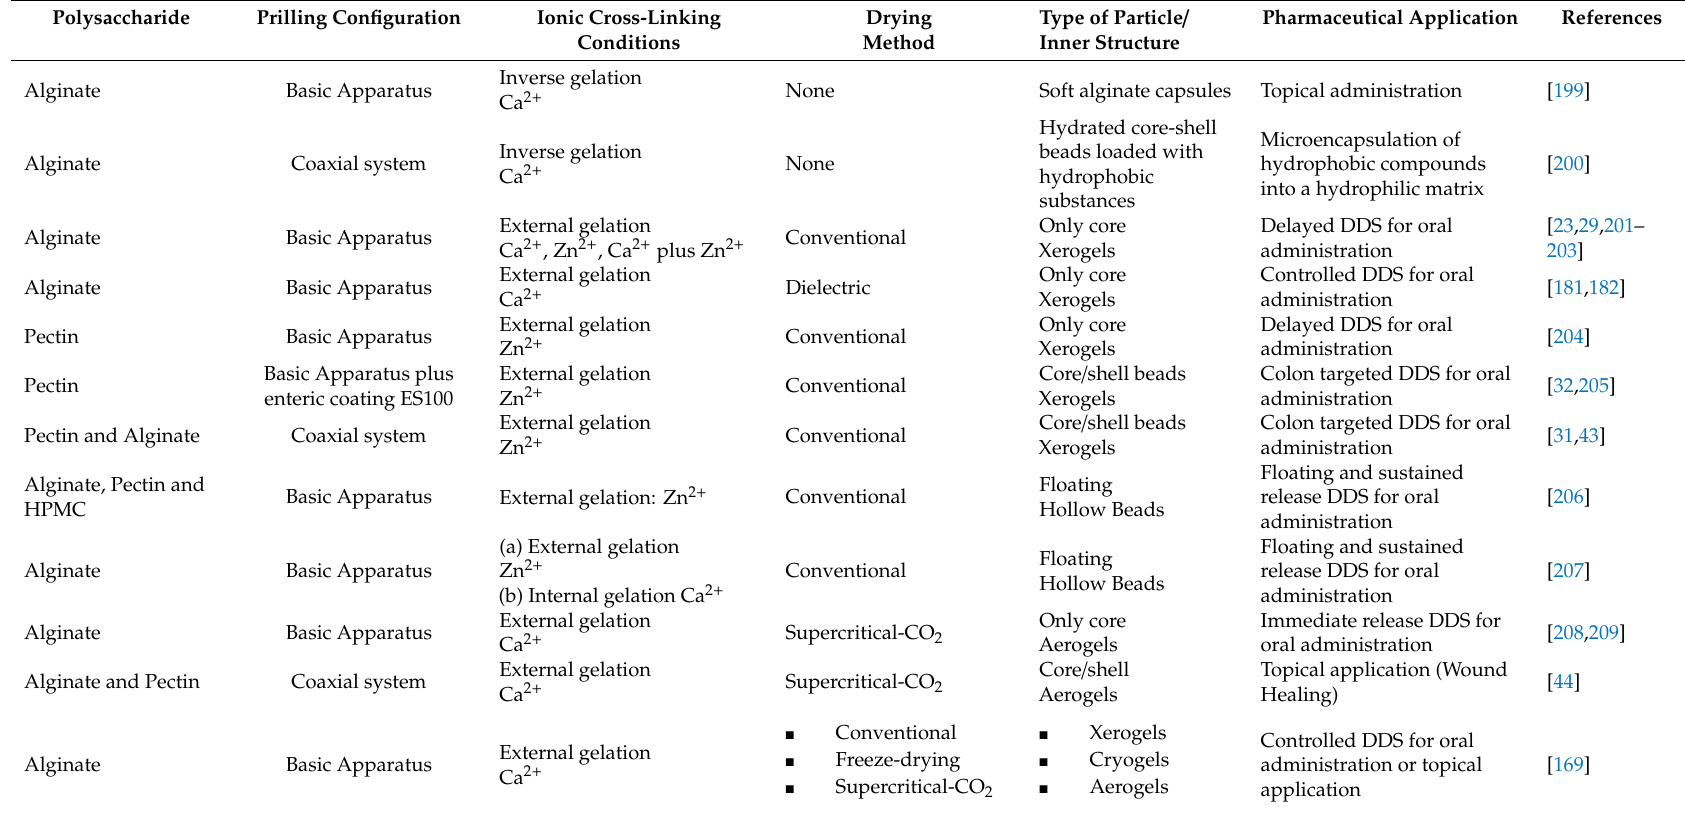
Table 2. Overview of PbHPs (polysaccharide-based hydrogel particles) produced by prilling / inotropic crosslinking / drying